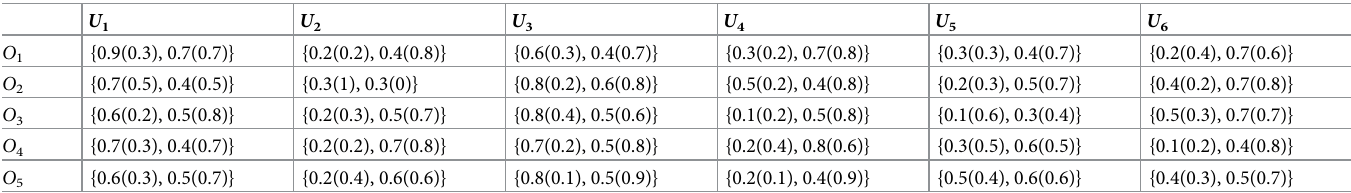
Table 5. Normalize PHF matrix Y 2 given by the second expert.